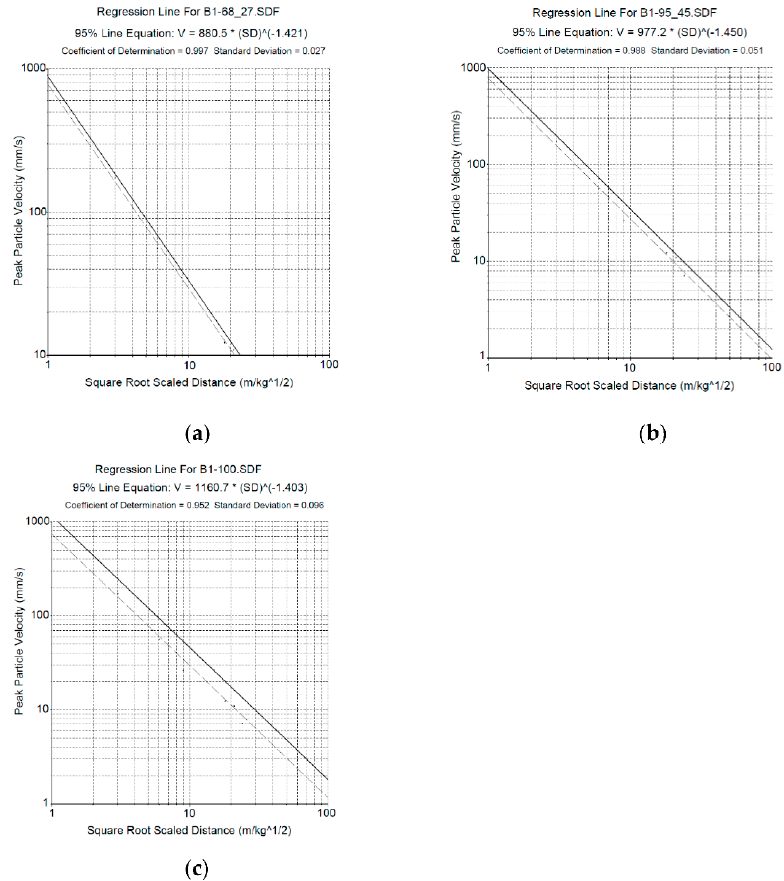
Figure 4. Regression line with the 95%-line equation, coefficient of determination and standard deviation for borehole B1: ( a ) confidence interval of 68.27%; ( b ) confidence interval of 95.45%; and ( c ) full dataset (100.00%).